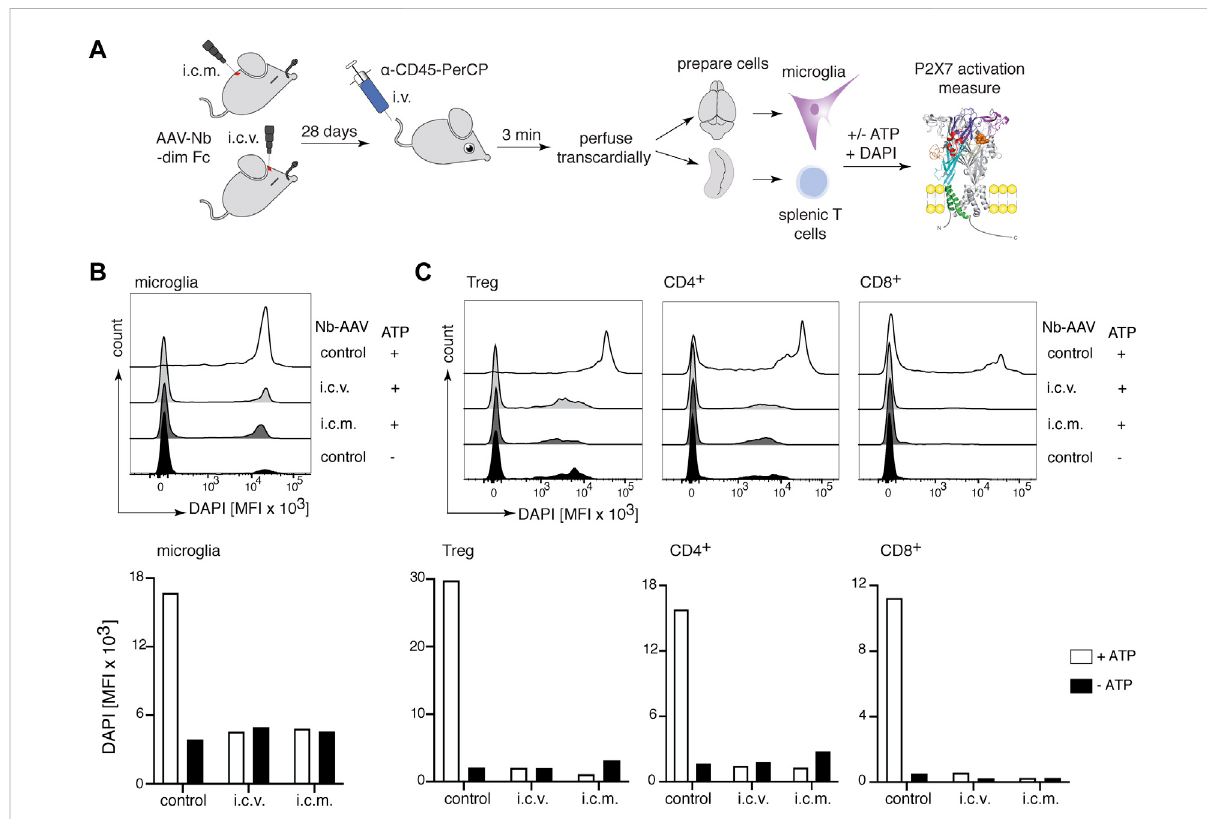
FIGURE 7 Complete inhibition of P2X7 on microglia and splenic T cells 28 days after intracerebral injection of P2X7 nanobody-encoding AAV1. (A) Mice were injected into the brain either i.c.v. or intracisterna magna (i.c.m.) with 10 11 viral genomes of an AAV1 vector coding for 13A7-dim Fc (Figure 1). After 28 days, P2X7 function, as determined by the ATP-induced DAPI uptake by microglia and splenic T cells, was analyzed by fl ow cytometry. Histograms show the MFI of DAPI uptake by microglia (B) or splenic Tregs and conventional CD4 + and CD8 + T cells (C) . Below, bar diagrams illustrate the ATP-induced DAPI uptake by the indicated cell population of AAV1-injected mice or control mice. Data are representative of two independent experiments. Dot plots shown are from a single mouse. An independent experiment refers to an experiment with a single mouse per condition, in which all mice were analyzed on the same